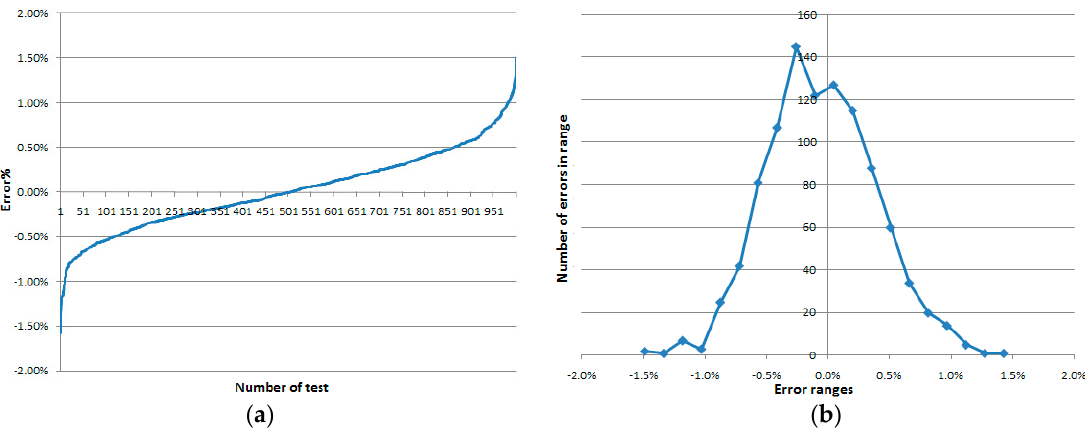
Figure 8. Analysis of the errors with NUGMC for the case in Figure 4c after 1000 tests: ( a ) calculated and sorted errors; ( b ) histogram of those errors.